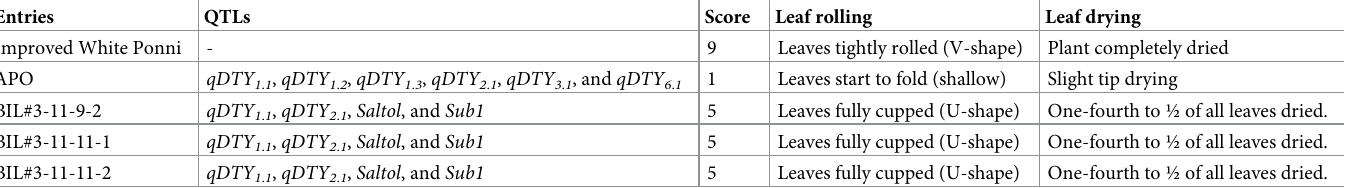
Table 7. Drought sensitivity scores of parents and BILs [29].